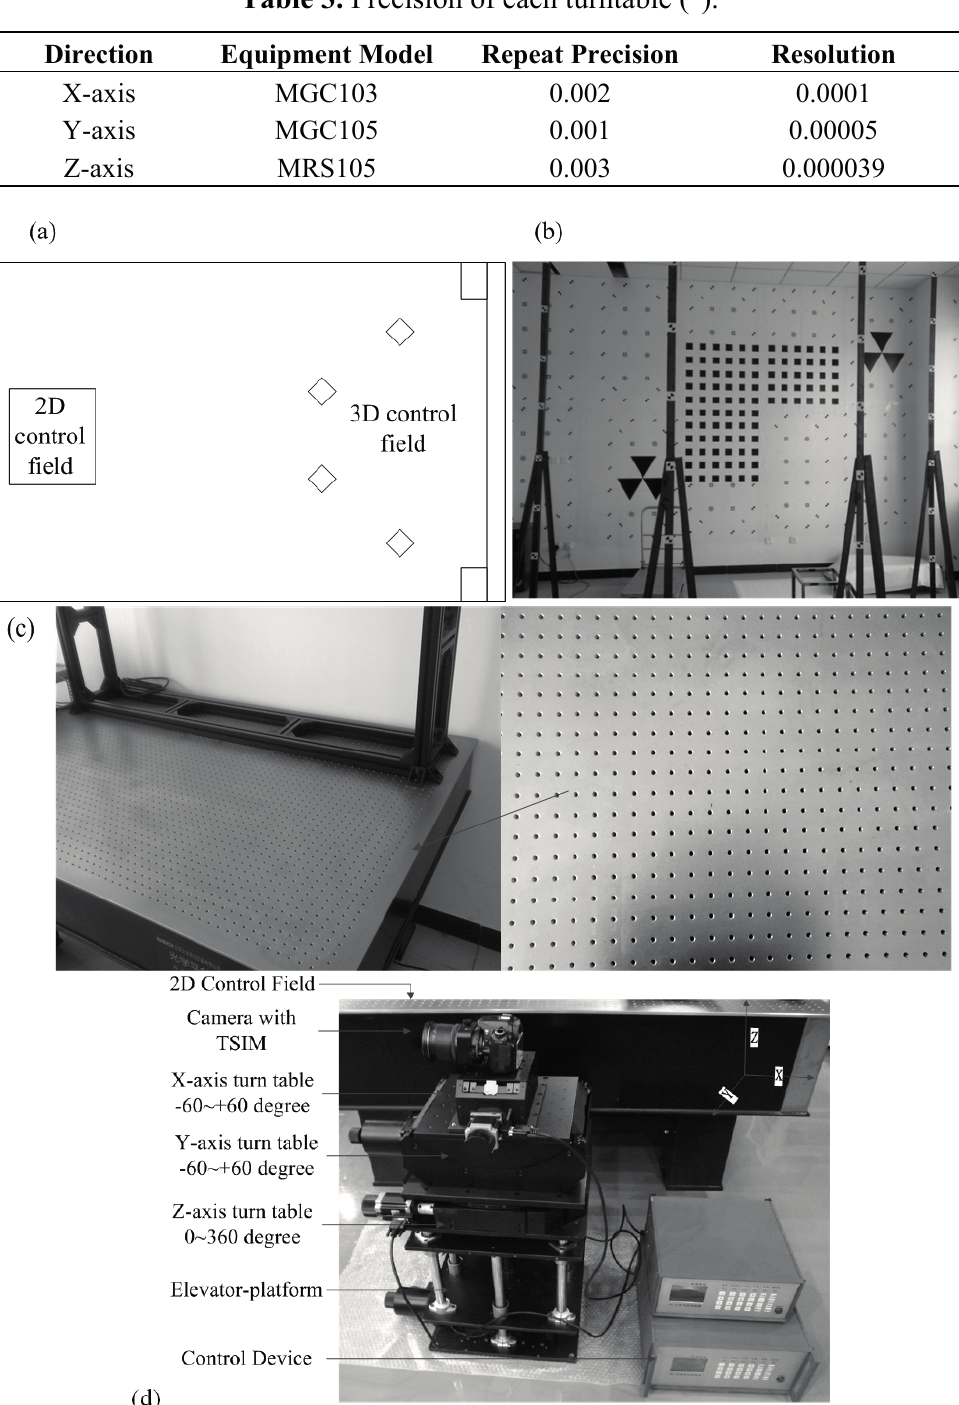
Figure 5. ( a ) Indoor calibration field; ( b ) 3DCF; ( c ) 2DCF and OP; and ( d ) tree-axis turntables and tilt-shift